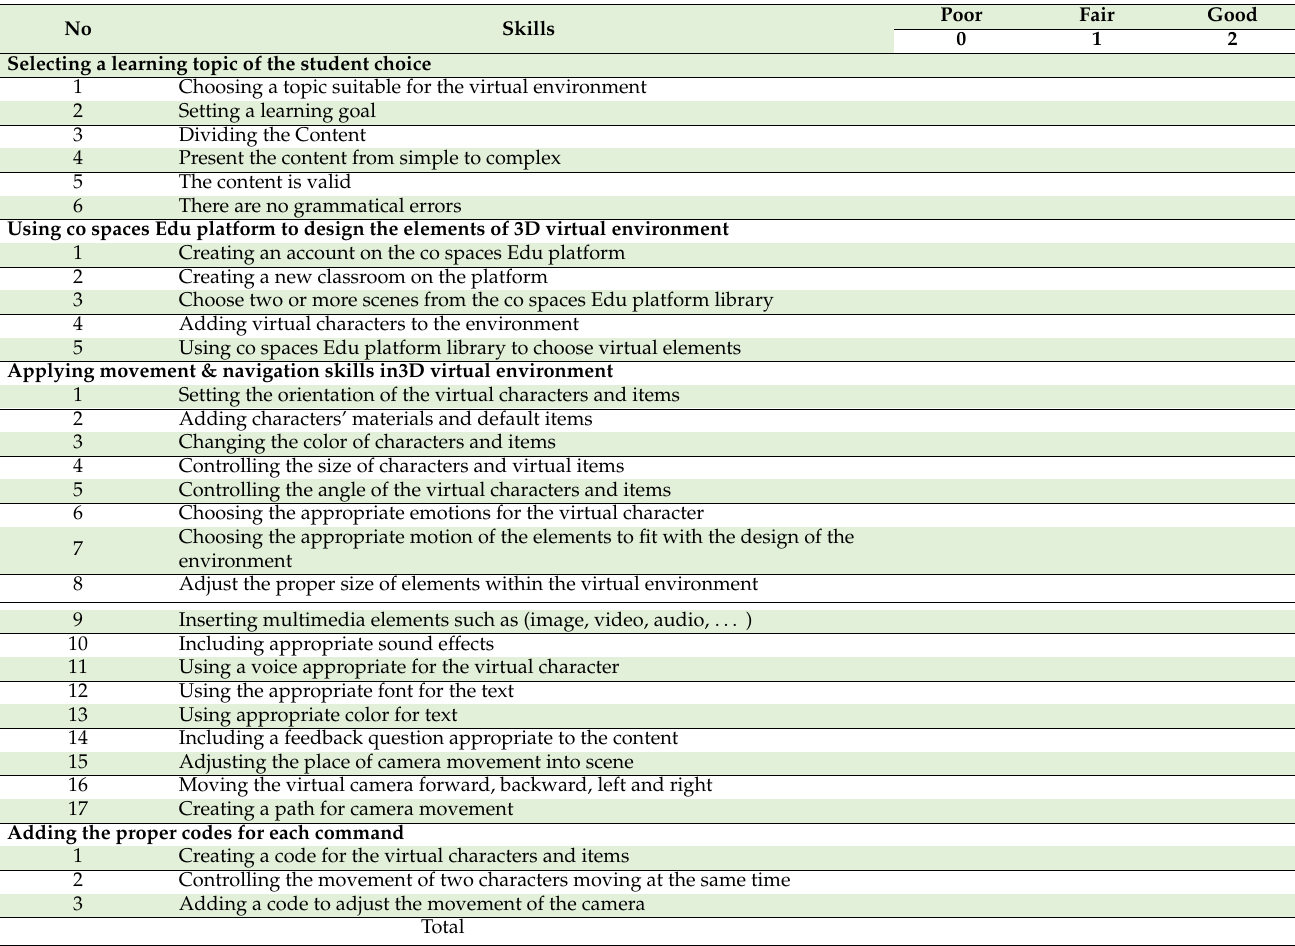
Poor Fair Good 0 1 2